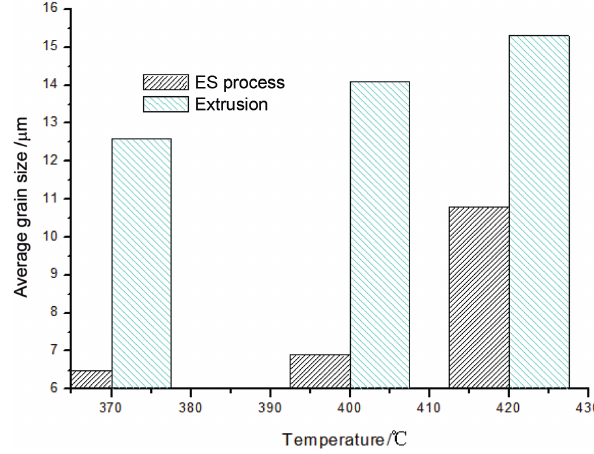
Figure 4: Average grain sizes fabricated by ES process and direct extrusion with different billet temperatures.